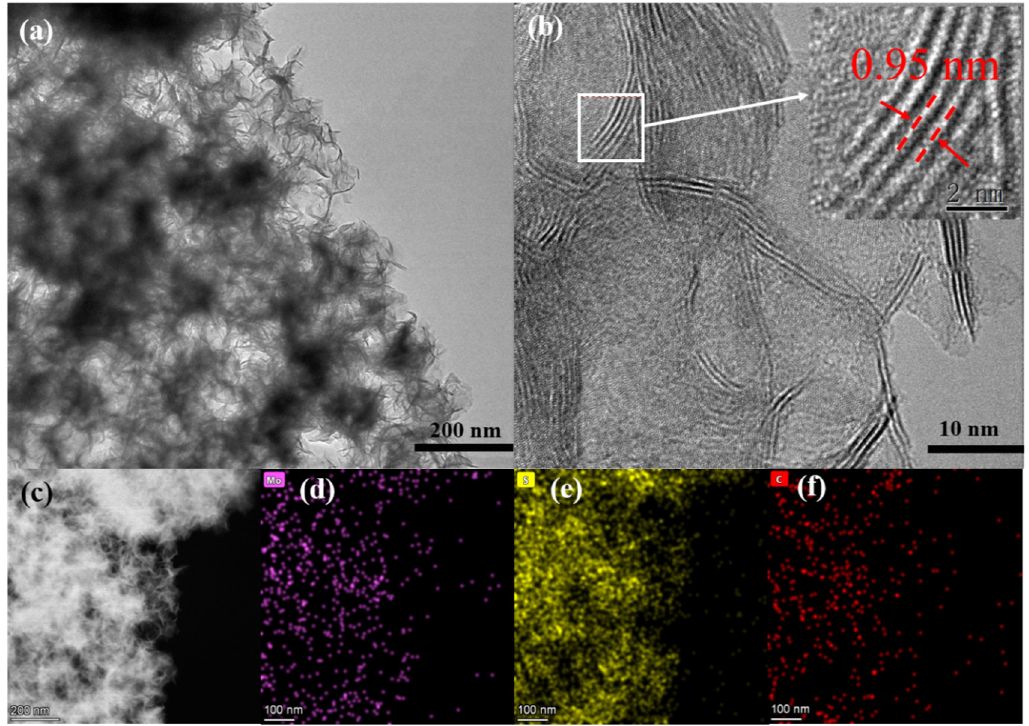
Figure 4. ( a , b ) TEM images and ( c – f ) STEM image and elemental mapping images of 1T-MoS 2 -600.